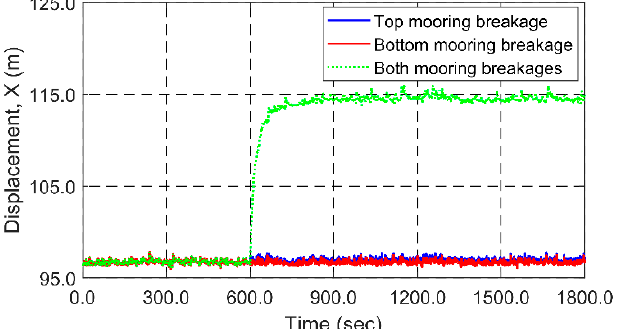
Figure 13. Time histories of the mooring tension in the middle location (Y = 0 m) as mooring lines in the middle location (Y = 0 m) are broken after 600 s ( H s = 2.0 m, T p = 7.0 s, current velocity = 0.6 m/s).